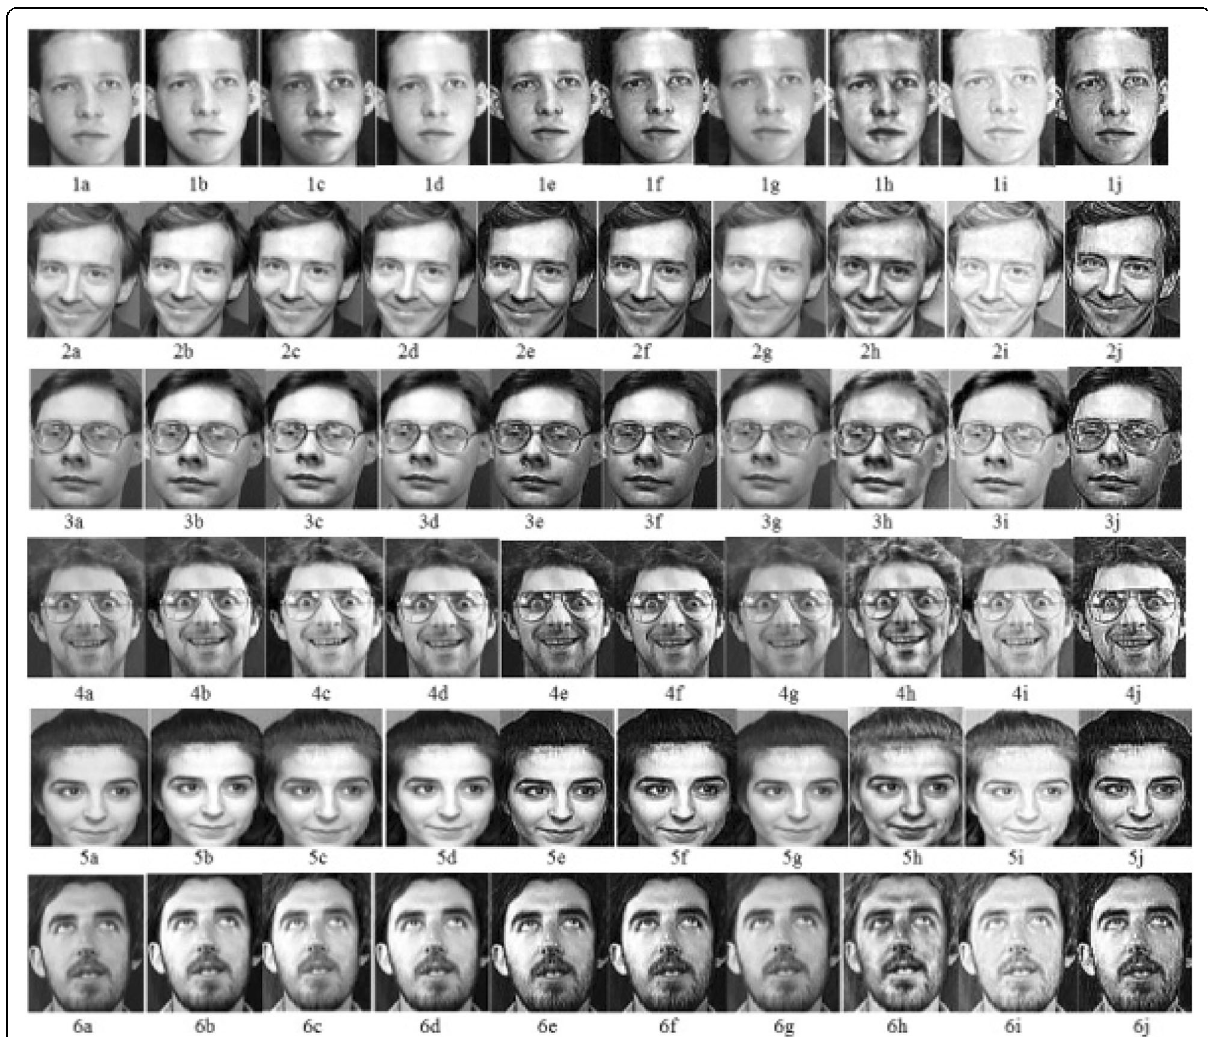
Fig. 11 Qualitative comparison of the different image enhancement algorithms on the ORL face dataset where Figs. 1, 2, 3, 4, 5, and 6 represent images of different subjects respectively. a – j denote the methods labeled as a original, b LCC, c HE, d IIA, e M_PSO, f M_GA, g BDPFHE, h CLAHE, i LLIE, and j proposed